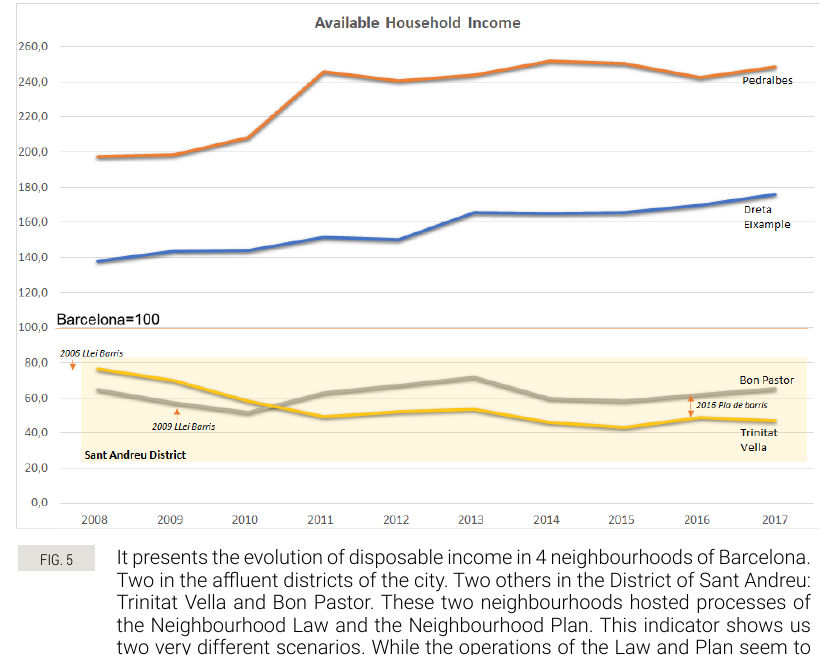
FIG. 5 It presents the evolution of disposable income in 4 neighbourhoods of Barcelona. Two in the affluent districts of the city. Two others in the District of Sant Andreu: Trinitat Vella and Bon Pastor. These two neighbourhoods hosted processes of the Neighbourhood Law and the Neighbourhood Plan. This indicator shows us two very different scenarios. While the operations of the Law and Plan seem to have an impact on the increase in disposable income in Bon Pastor, everything indicates that its impact on Trinitat has been less. The Image also indicates that since the 2008 crisis, inequalities between the different areas of Barcelona have increased dramatically. Source: Ajuntament de